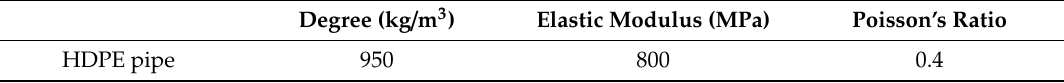
Table 2. Physical properties of the high-density polyethylene pipe.